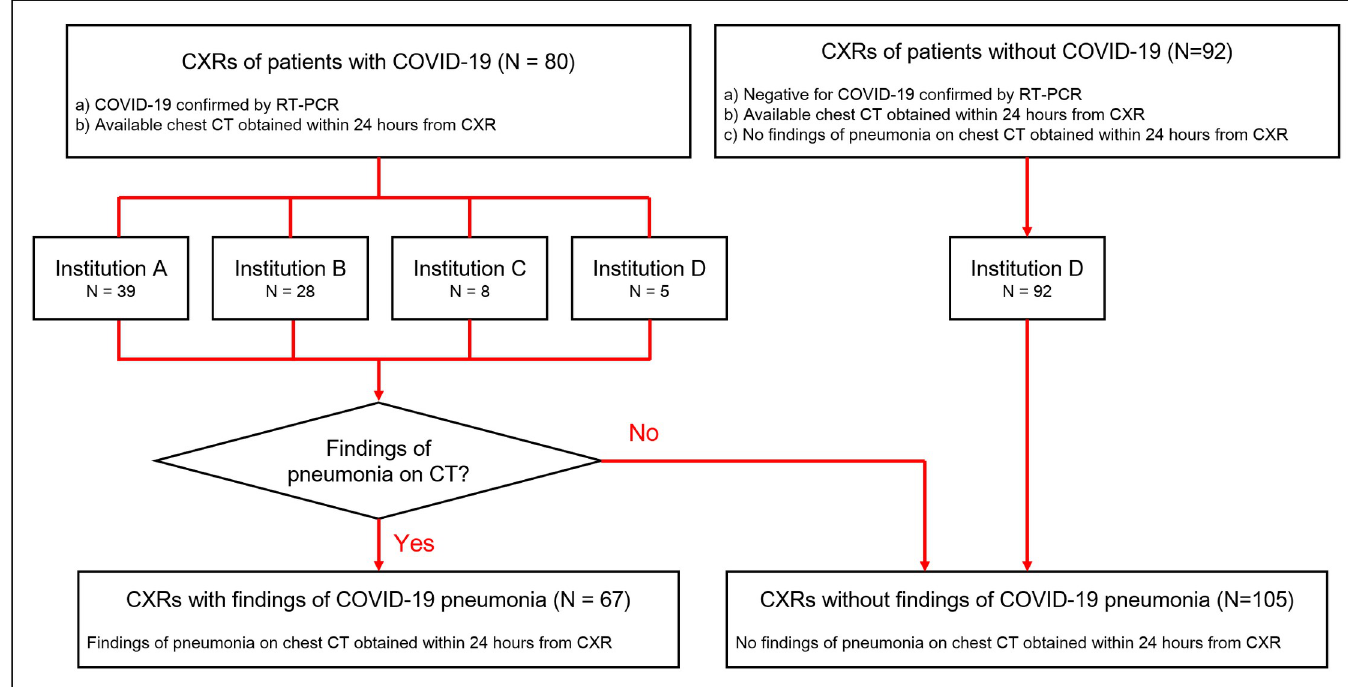
Fig 1. Flow diagram for patients’ inclusion. A total of 80 patients with COVID-19 were retrospectively included from four institutions, while 92 patients without COVID-19 were included from single institution. Among patients with COVID-19, 67 exhibited findings of pneumonia on chest CT obtained within 24 hours from CXR, while the other 13 patients did not exhibited any findings of pneumonia on chest